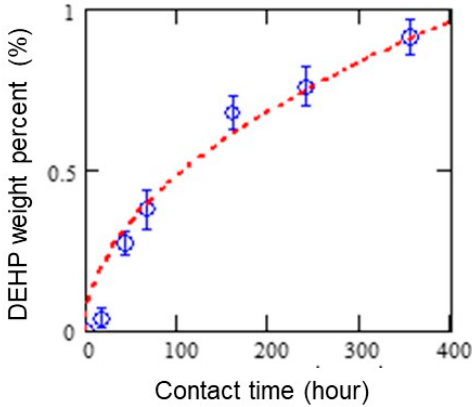
Figure 3. Time-dependent migration of DEHP from a PVC (7.4% (w / w)) to PE sheet. The error bars represent one standard deviation of the three measurements.